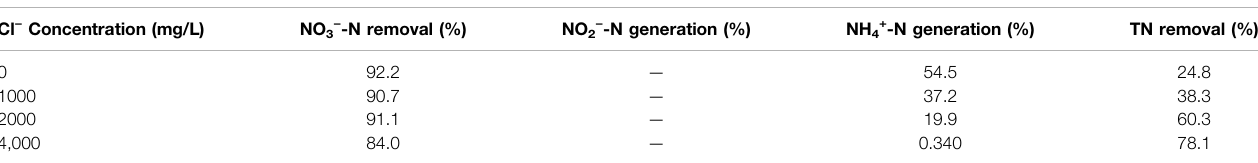
TABLE 1 | Effects of Cl − on the Co 3 O 4 / Ti/IrO 2 -RuO 2 /Ti NO 3 − -N removal system. Cl − Concentration